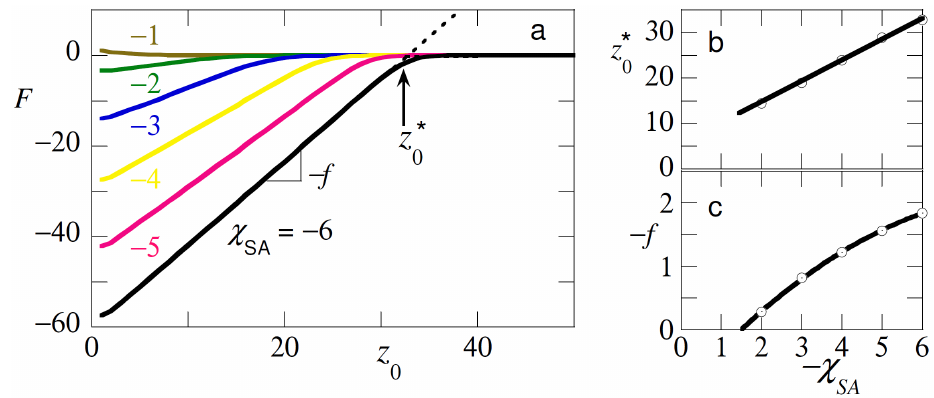
Figure 2. ( a ) Free energy F in units of k B T of a test chain with N = 100 segments adsorbed on an impenetrable surface with adsorption strength χ S A as indicted, as a function of the distance z 0 of one of the ends above the surface. Both, the slope which is related to the ‘retraction’ force − f and z ∗ where the chain ‘snaps’ loose, are indicated. ( b ) The detachment distance z ∗ f (in units of k B T / b ) as a function of the adsorption energy χ SA . Conditions identical to